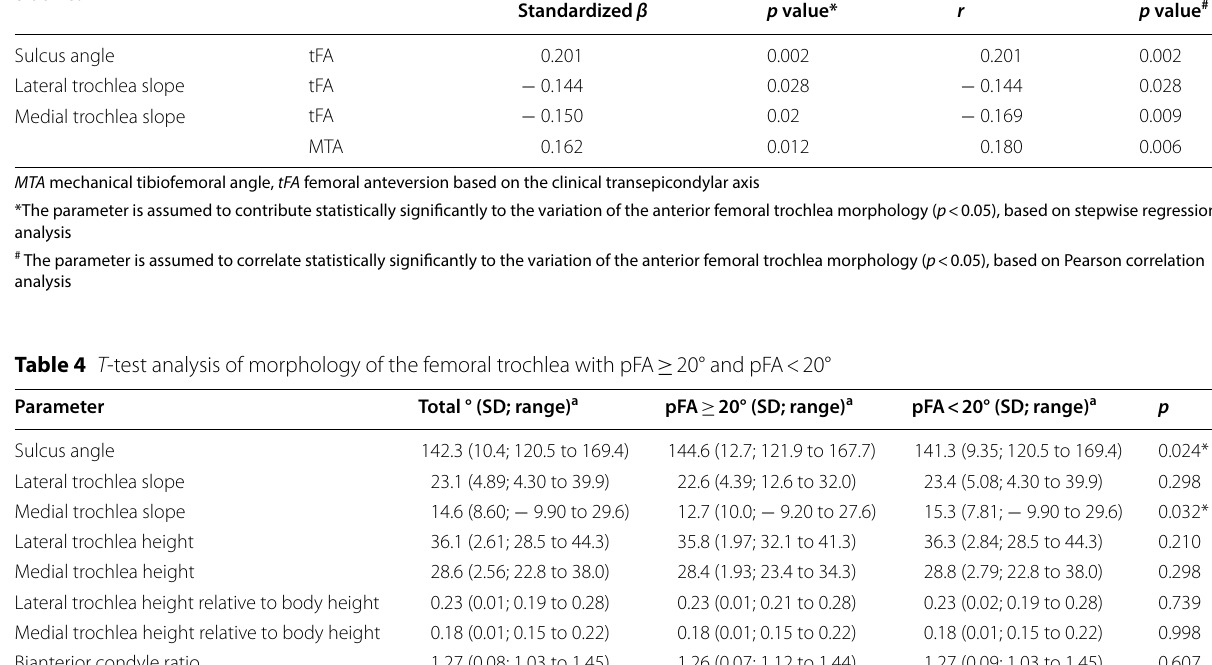
pFA femoral anteversion based on the posterior condylar line, tFA femoral anteversion based on the clinical transepicondylar axis * p < 0.05; ** p < 0.01 a Values are given as the median, with the standard deviation and range in